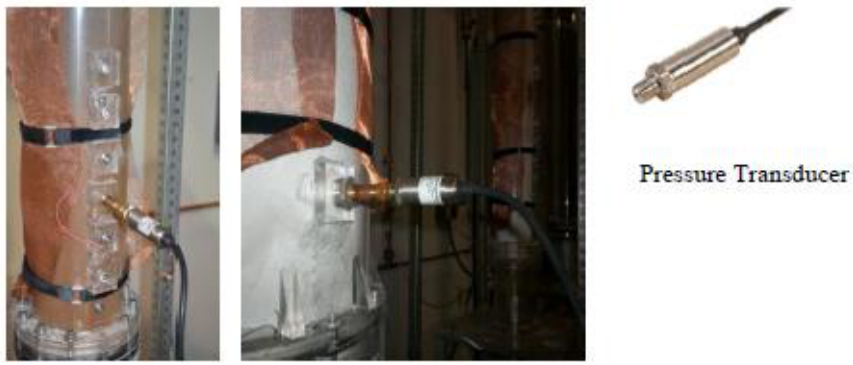
Figure 10. Pressure transducer being mounted on the 0.14 m and 0.44 m inner diameter fluidized